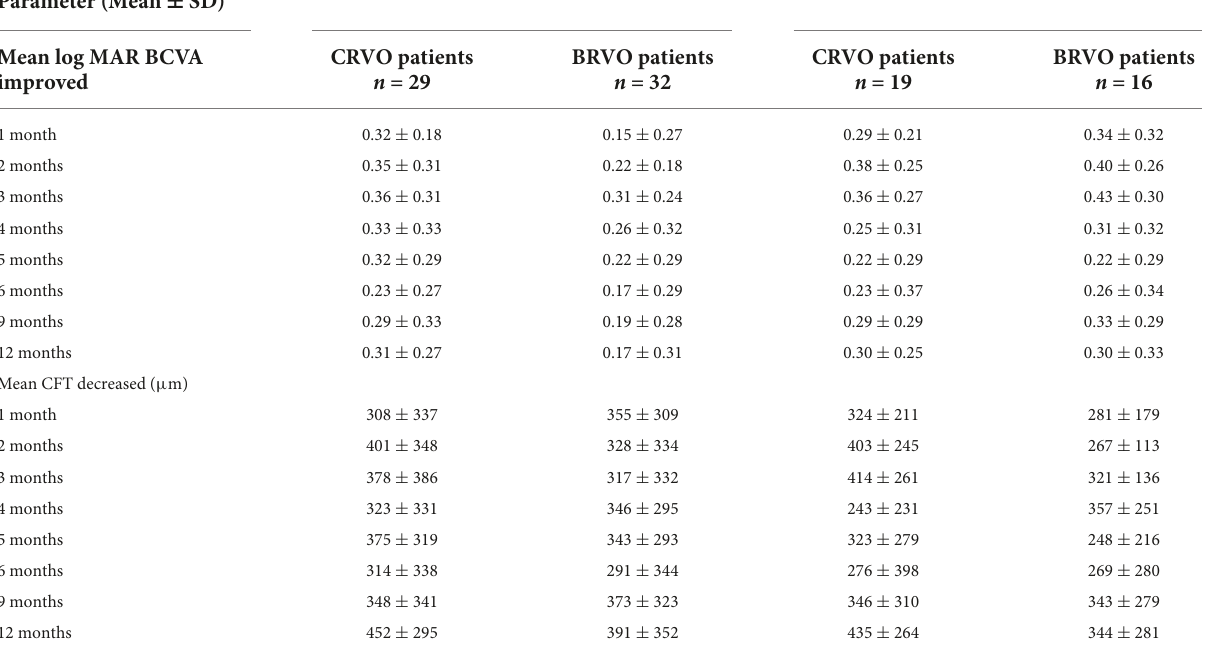
TABLE 2 Log MAR BCVA improved and CFT decreased between the two